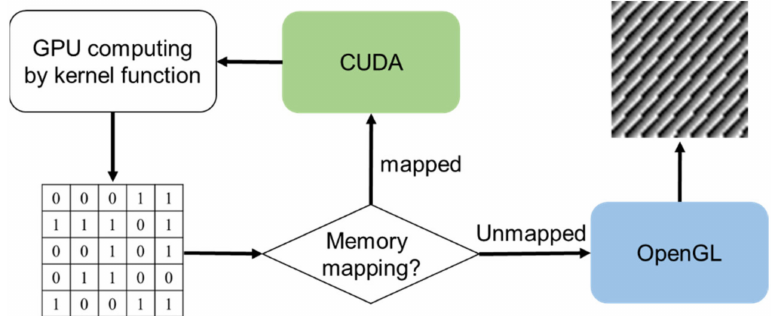
Figure 4. Schematic diagram for CUDA-OpenGL interoperability. CUDA and OpenGL share the same memory by mapping the buffer with CUDA. Once it has unmapped the buffer, OpenGL can directly render the calculated